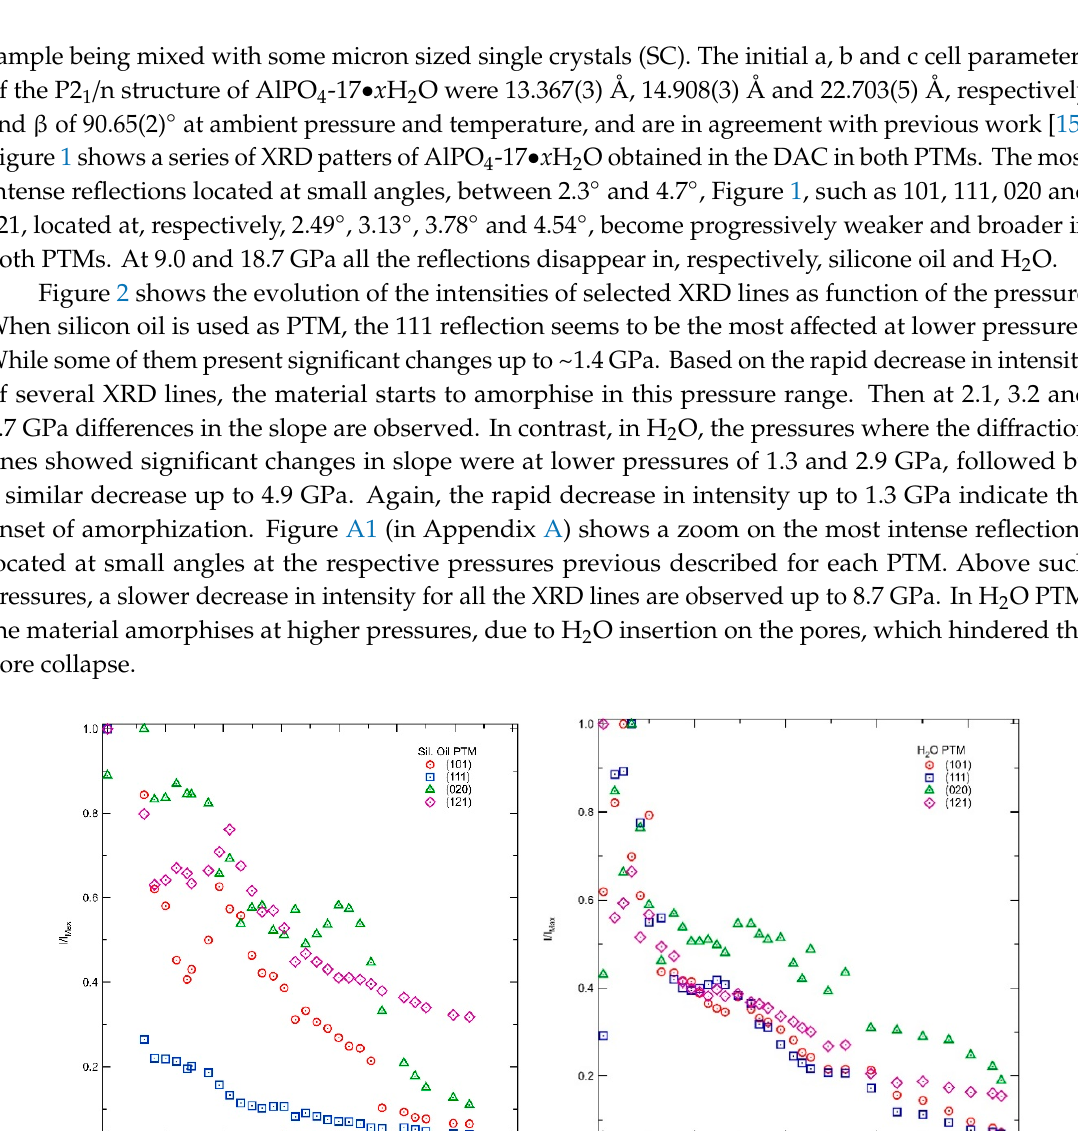
Figure 3. Lattice parameters as a function of pressure in silicone oil (red) and in H 2 O (blue) PTM.